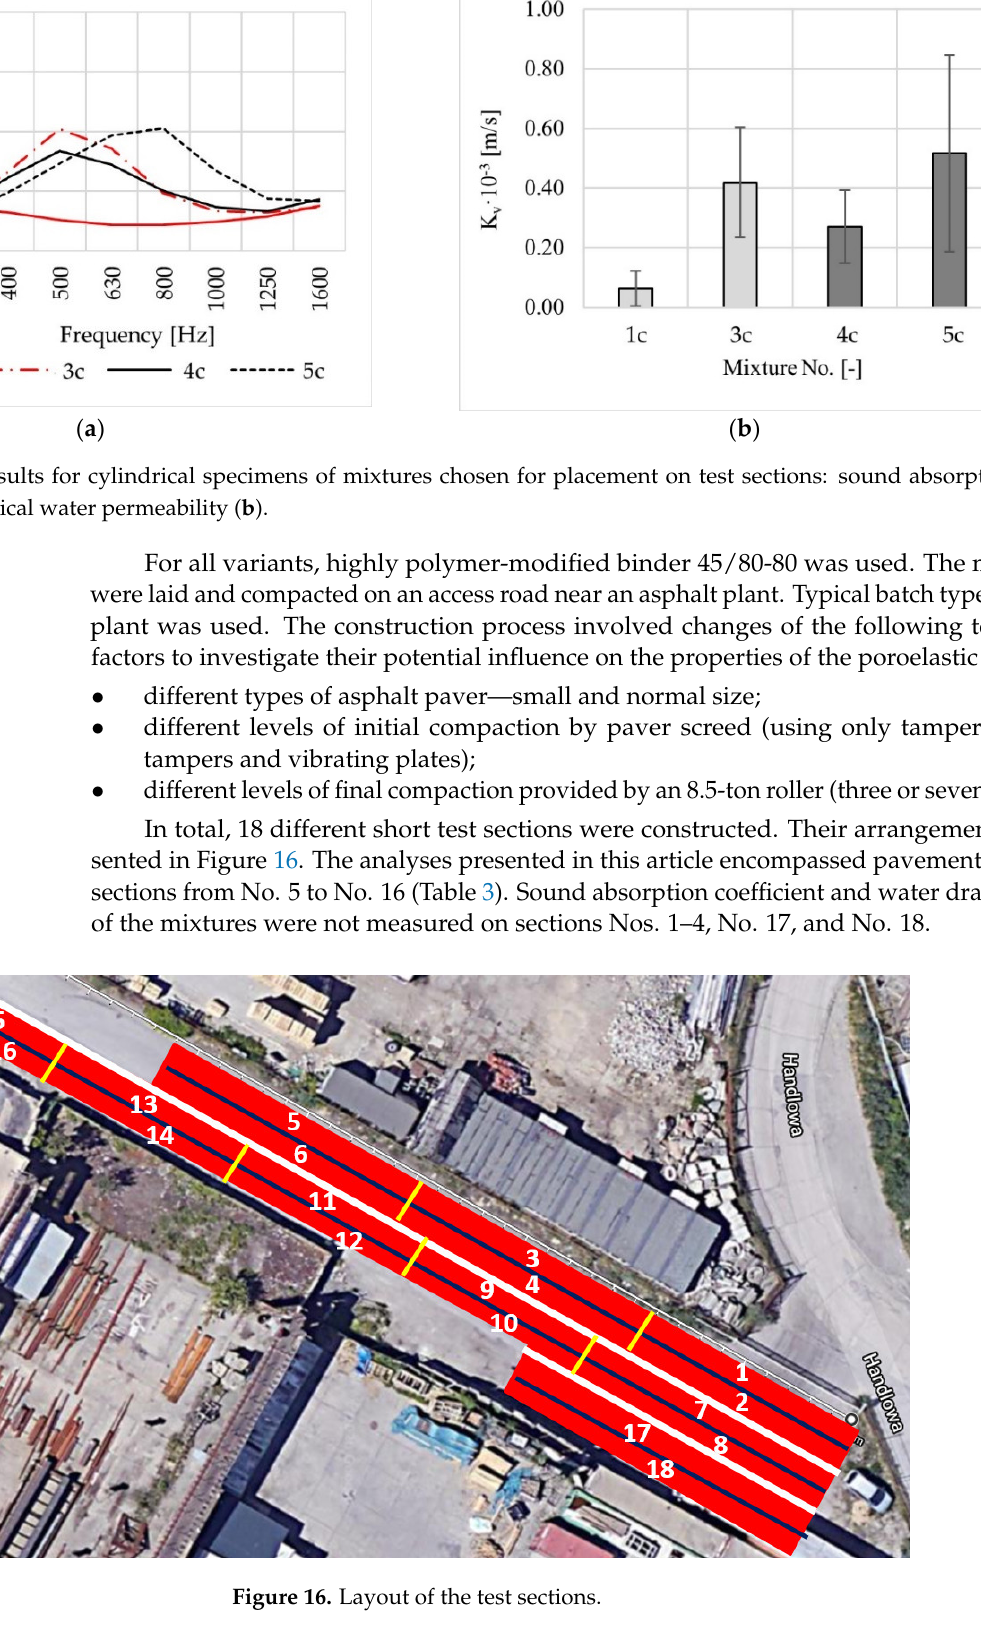
Layout of the test